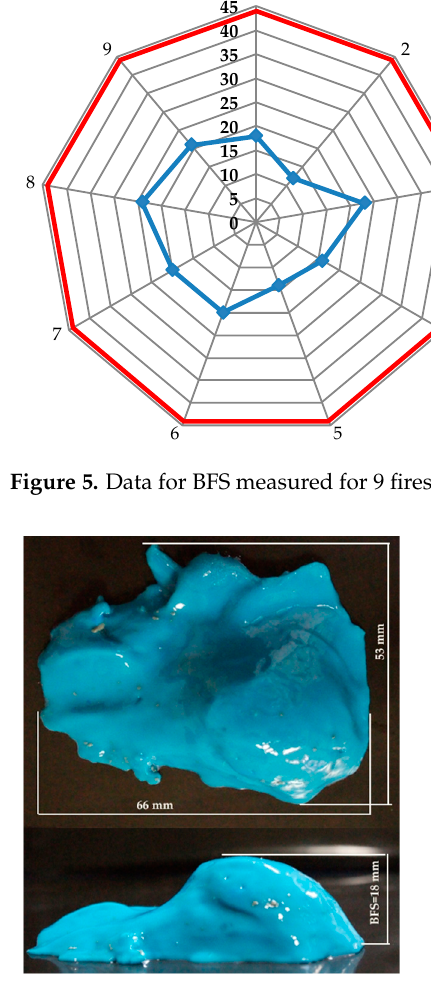
Figure 6. Cavity shape in the ballistic clay, obtained with a molding resin.